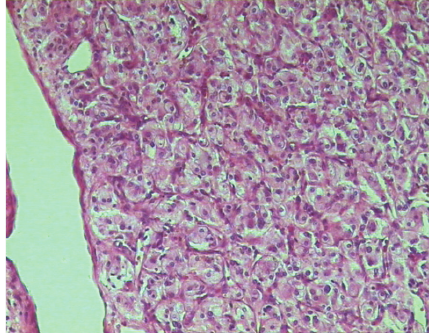
Figure 4: Thereis no tumor cell mitosis. Thereis no necrosis, no sig- nificantpleomorphismofthecellsortheirnuclei(includingspindle- shaped cells, hyperchromasia of the nuclei, and large nucleoli), no tumorinfiltrationoftheadrenalglandcorticaltissues,novascularor perineural invasion, and no invasion into the adrenal gland capsule (including the periadrenal tissues).